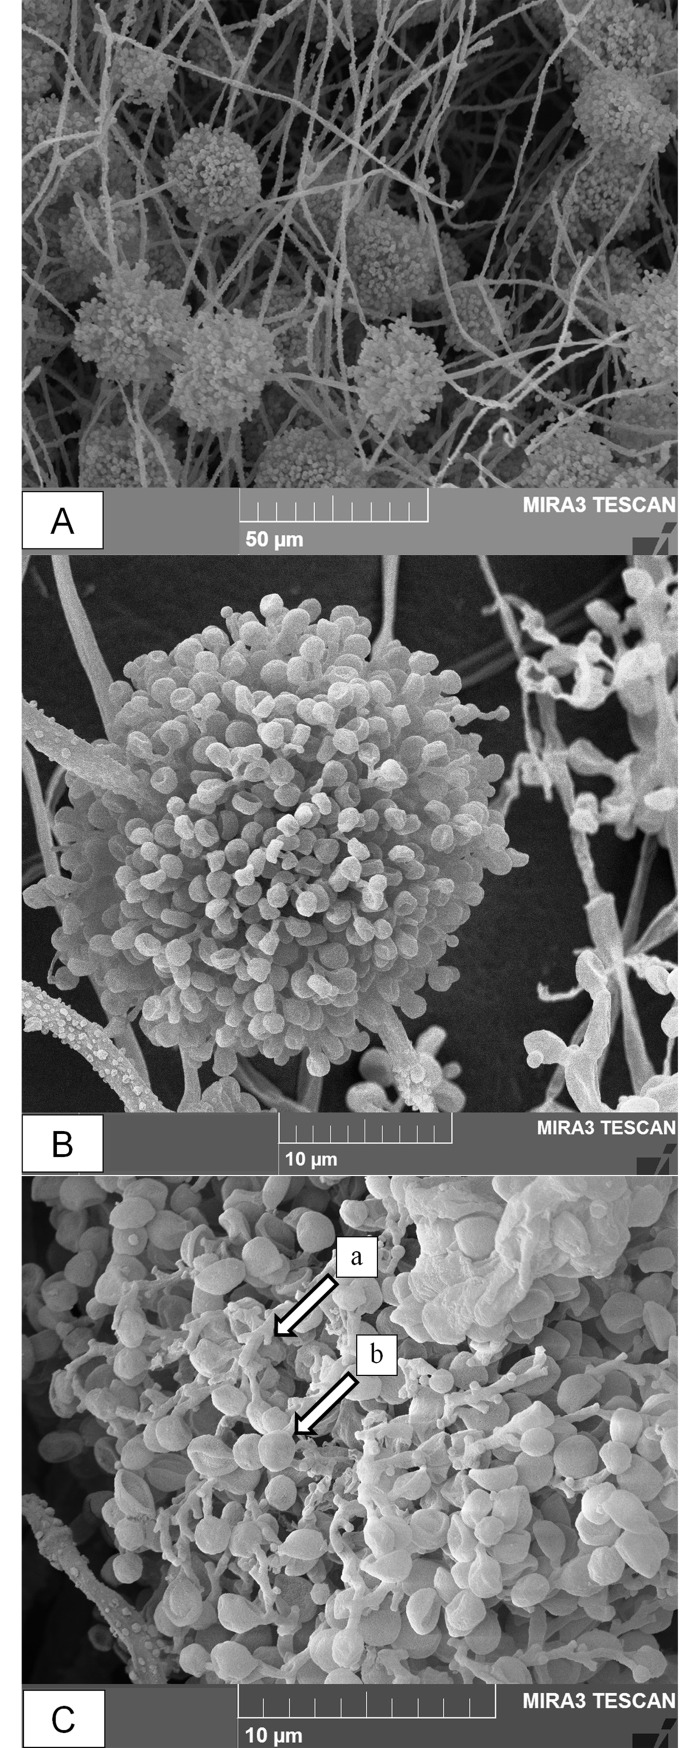
Scanning electron micrographs of B. bassiana ARP14 on the cadaver of adult Riptortus pedestris (F.) (Hemiptera: Alydidae).(A) Group of clustered conidigenous cells on insect cadaver magnification: 1.49 K×), (B) Short globose shaped cluster of conidigenous cells (magnification: 7.5 K×), and (C) Conidia shape and rachis structure (magnification: 10.1 K×). Arrows indicating (a) the denticulate rachis elongated in a long zig-zag extension (b) conidia having globose shaped terminated in a narrow apical extension of rachis.